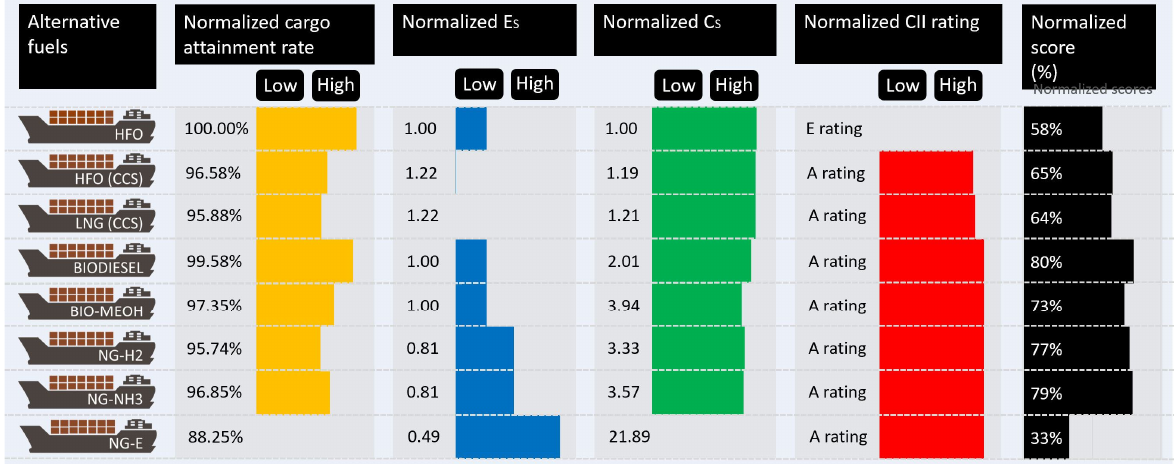
Figure 10. Normalised performance factors for a cargo of 1.25 m 3 /ton transported for 10,000 nm and overall score, assuming equal weighting of the four factors (cargo attainment rate, specific energy, specific cost, and CII).